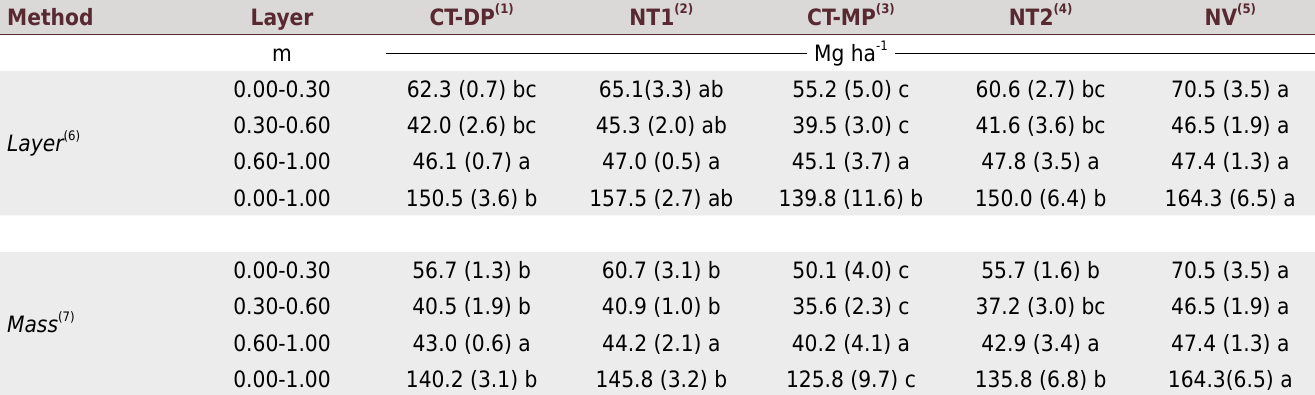
Table 3. Estimates of carbon pools by different methods of bulk density correction in a clayey Latossolo Vermelho Distrófico (Typic Haplustox) after 31 years of cultivation under different tillage systems in the Cerrado